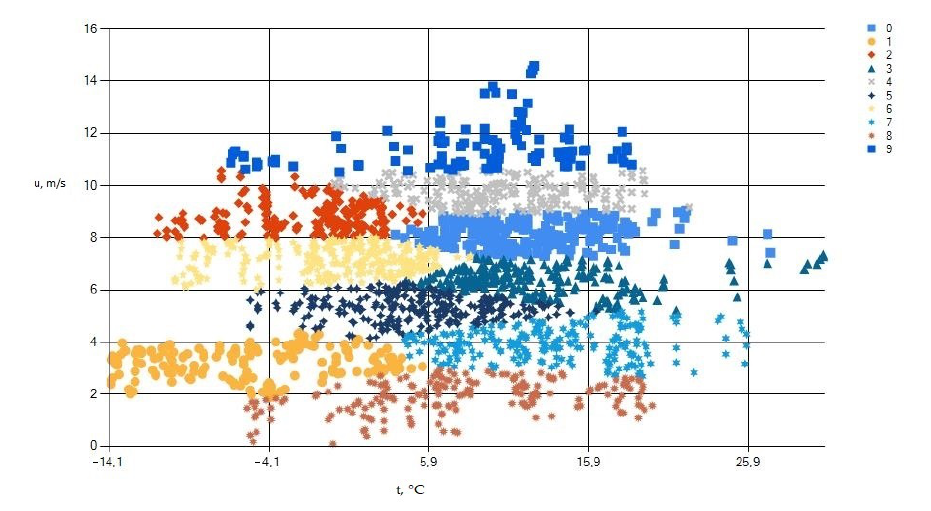
Figure 6. The results of ABL cluster analysis in